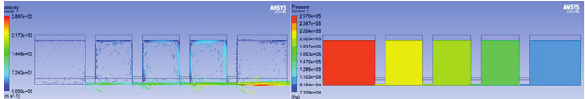
Figure 4. Velocity vectors and static pressure distribution